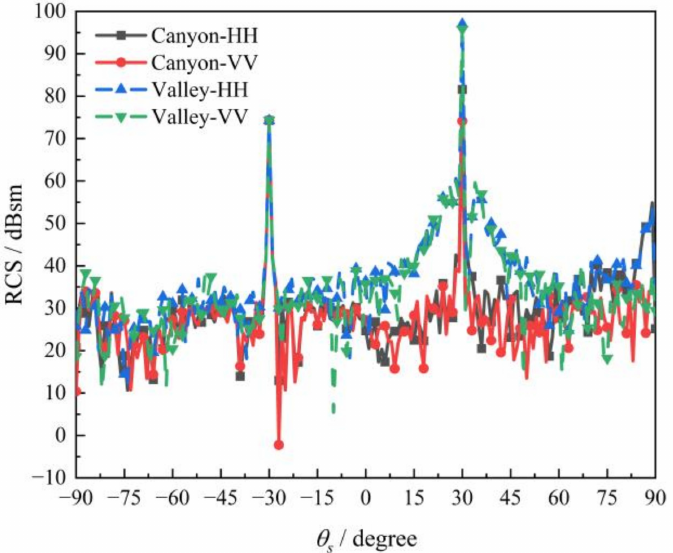
Figure 13. Bistatic RCS for a missile-like target above the canyon and valley composite rough